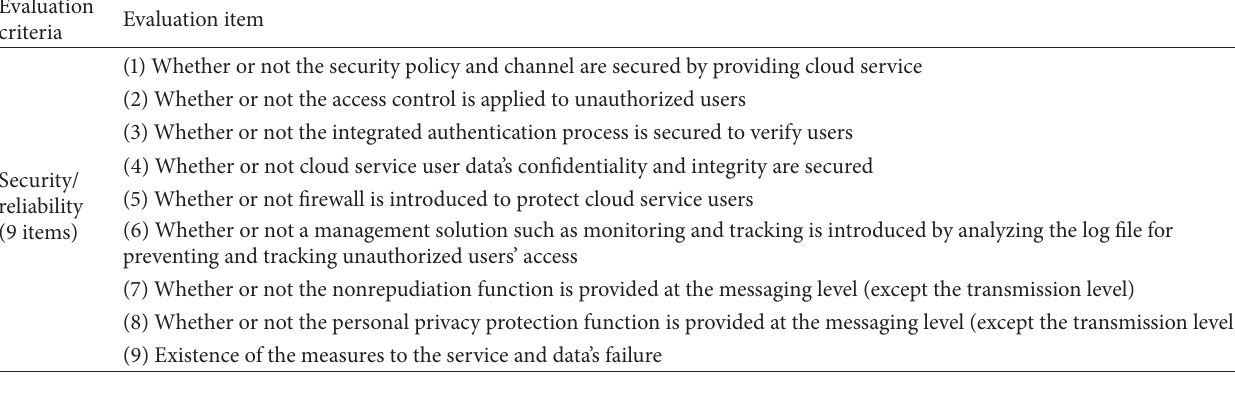
Table 6: Evaluation items of security and reliability.